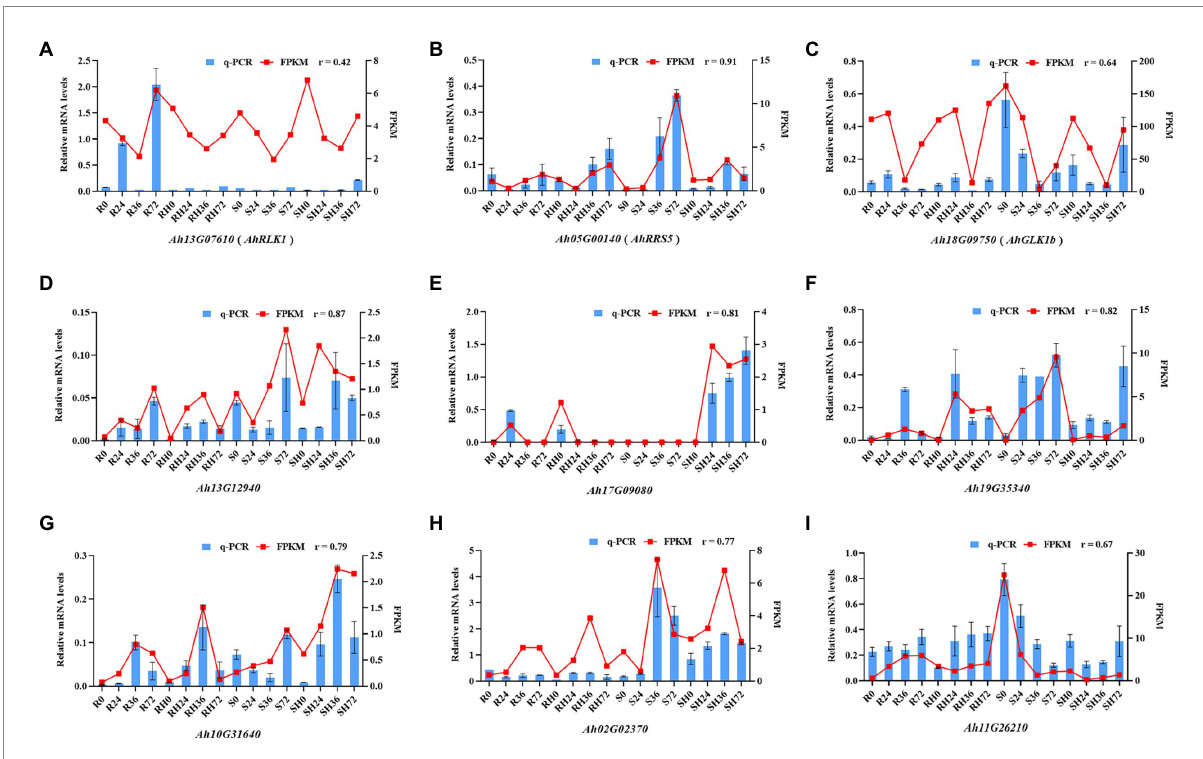
FIGURE 9 Coefficient analysis of the consistency between qRT-PCR data and RNA-Seq results. Error bars indicate ± SE. r represents the correlation